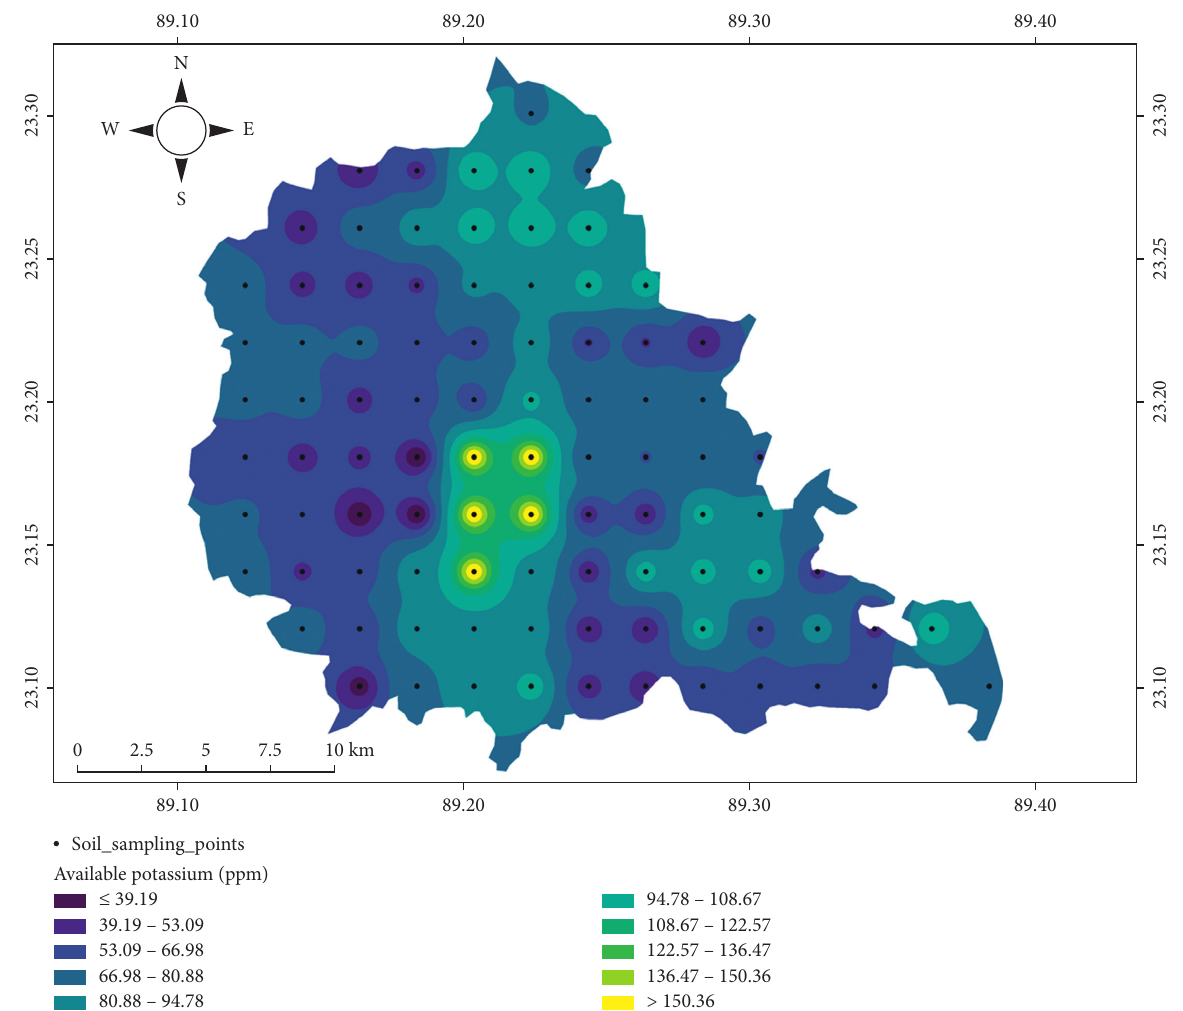
Figure 10: Spatial distribution of available soil potassium (Av K) contents in the study